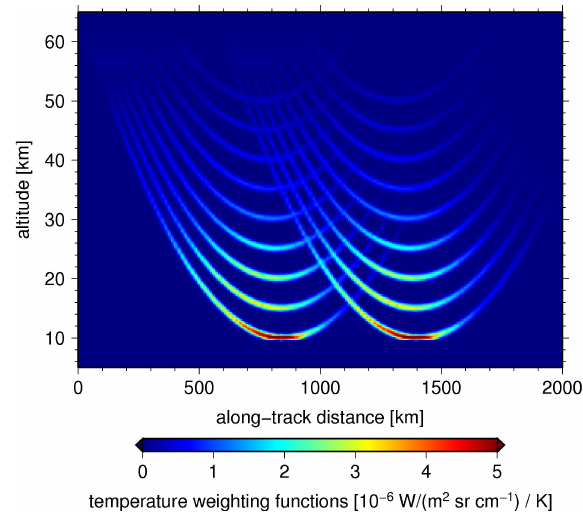
Fig. 4. Temperature weighting functions for the PREMIER IRLS at 790.75cm − 1 for mid-latitude atmospheric conditions. Weight- ing functions are superimposed by taking the maximum sensitivity at each atmospheric grid point. The plot shows weighting functions for 10, 15, ..., 55km tangent point altitude. Tangent points are sep- arated by 500km horizontal distance. Note that the measurement grid of the instrument is ten times finer in the vertical and horizon- tal domain than presented in this figure. The instrument is located on the